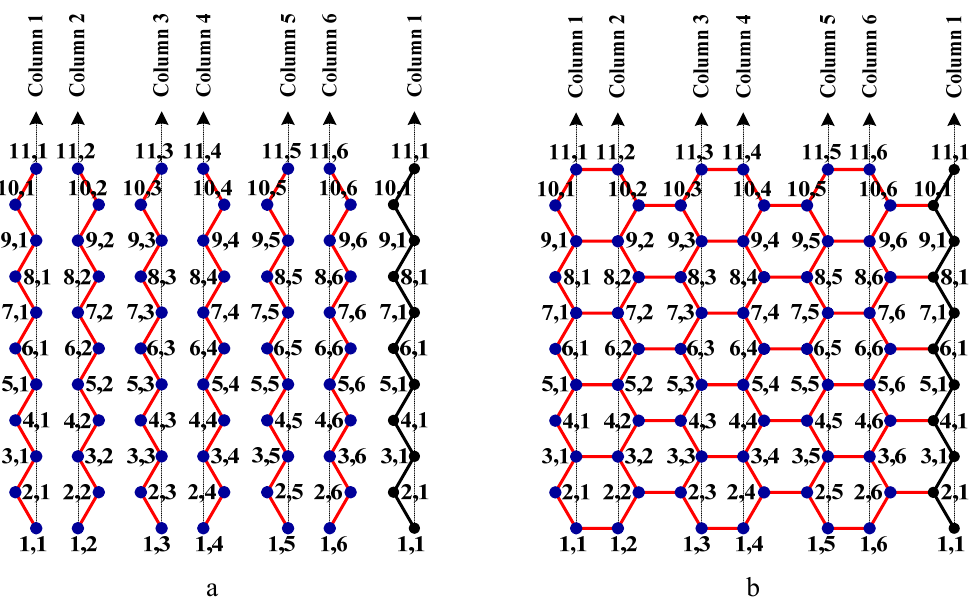
columns and each column has 11 rows of vertices. Each vertex is labeled based on its location with respect to row and column. The first column and the last column of the carbon hexagonal sheet are merged to form a carbon